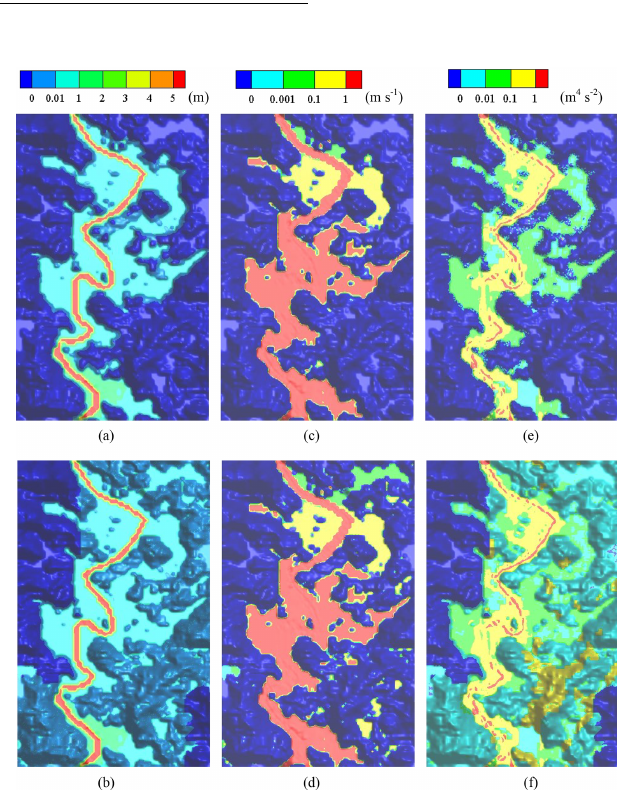
Figure 24. Simulation results at t = 17h. Panels (a) and (b) are wa- ter depth (m) for Case A and Case B. Panels (c) and (d) are velocity (ms − 1 ) for Case A and Case B. Panels (e) and (f) are the flux term (m 4 s − 2) for Case A and Case